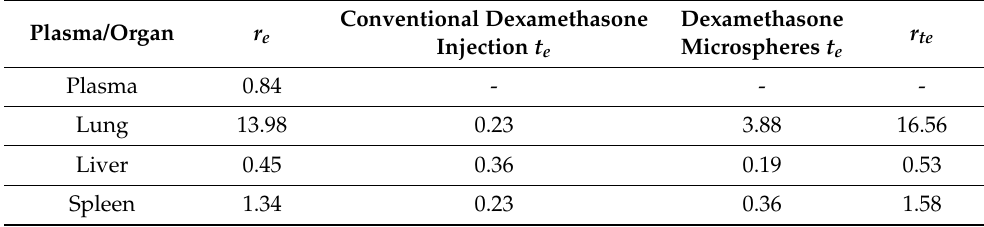
Table 1. Comparative biodistribution of dexamethasone in plasma, lung, liver and spleen after intravenous of conventional dexamethasone injection and developed dexamethasone microspheres. Plasma/Organ r